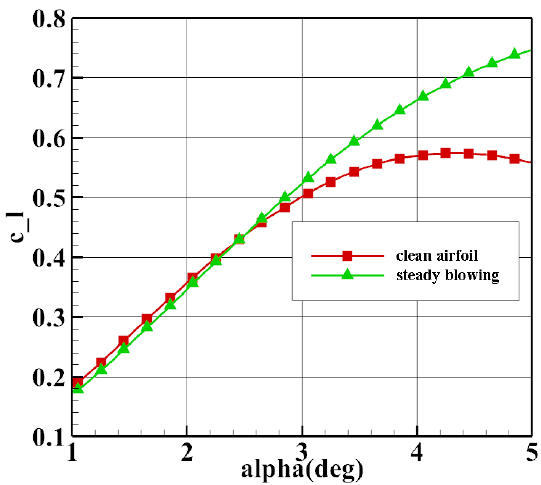
Figure 6. Comparison of lift coefficients with and without blowing .